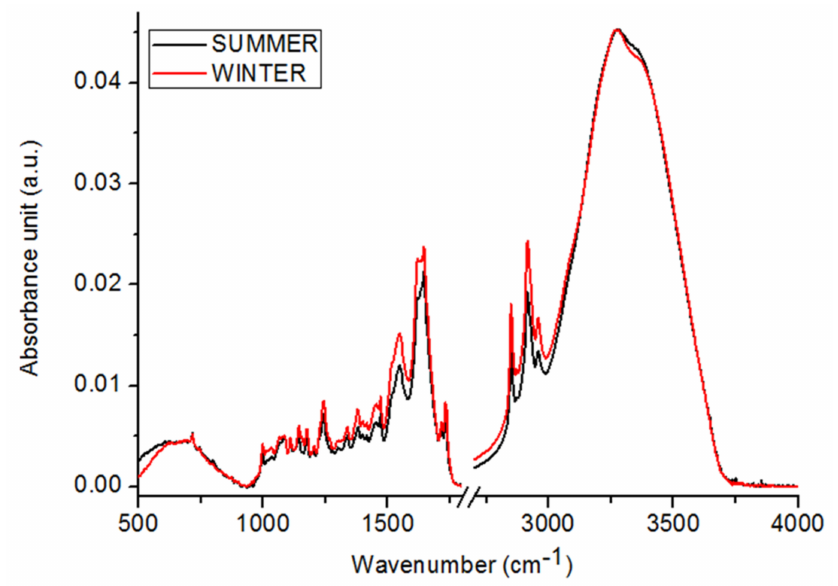
Figure 2. FTIR spectra of summer (black spectrum) and winter (red spectrum) of C.